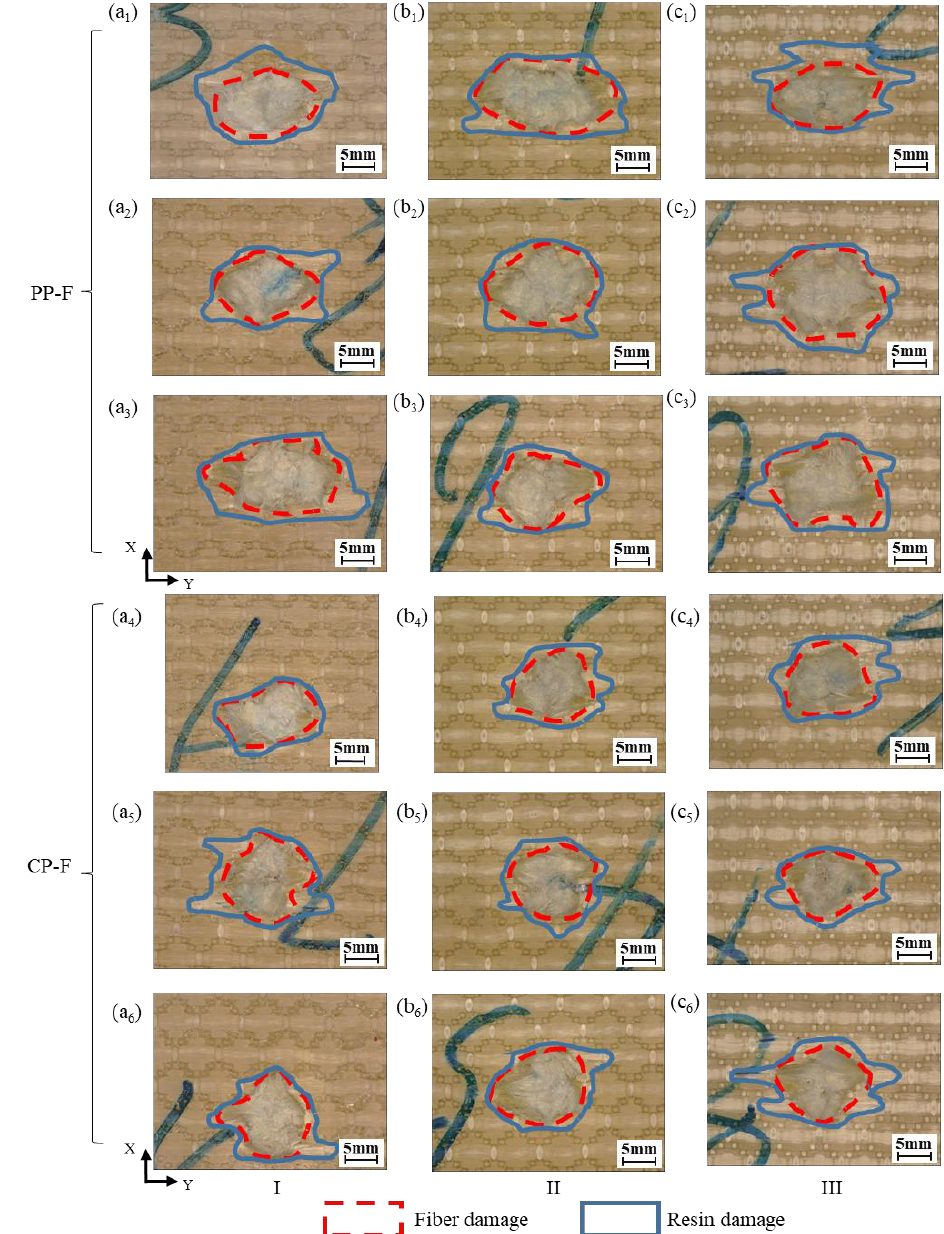
Figure 8. Fiber/resin damage morphology of composite panel after ballistic tests of front face: ( a 1 )−( a 3 ) PP-F of sample I; ( a 4 )−( a 6 ) CP-F of sample I; ( b 1 )−( b 3 ) PP-F of sample II; ( b 4 )−( b 6 ) CP-F of sample II; ( c 1 )−( c 3 ) PP-F of sample III; ( c 4 )−( c 6 ) CP-F of sample III. (PP-F: front face of partially penetrated panel; CP-F: front face of completely penetrated panel.)